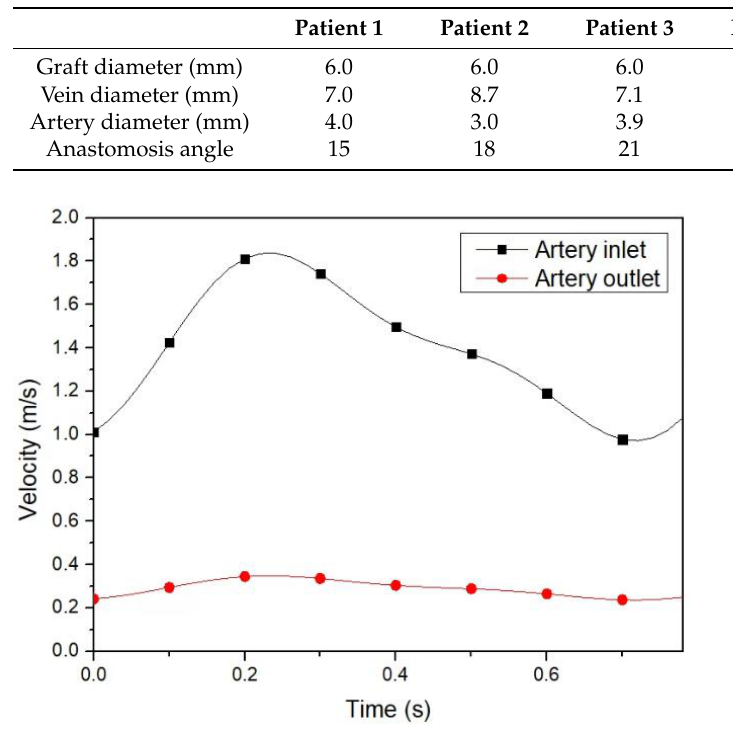
Table 1. Diameter and anastomosis angle of the patients.